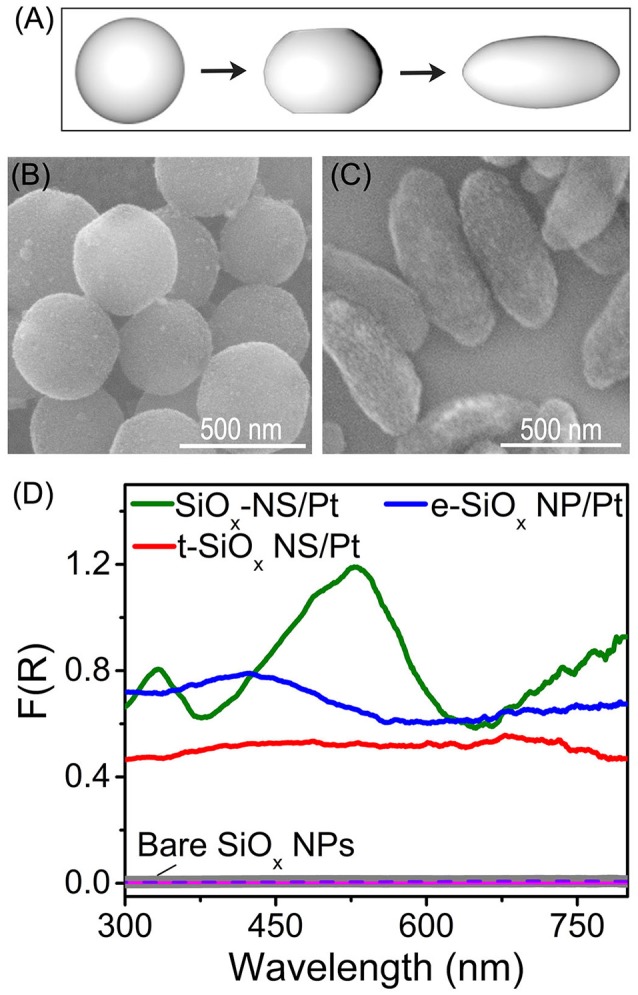
(A) Schematic illustration of geometry of SiOx NSs (left), t-SiOx NSs (middle), and e-SiOx NPs (right), highlighting the difference of their geometric symmetries. (B,C) SEM images of t-SiOx NSs (B) and e-SiOx NPs with Pt nanocrystals loaded on their surfaces. (D) DRS spectra of powders of bare silica nanoparticles (SiOx NSs, t-SiOx NSs and e-SiOx NPs) and the corresponding SiOx/Pt composite particles with 1 wt.% loading of Pt nanocrystals on the silica nanoparticles.